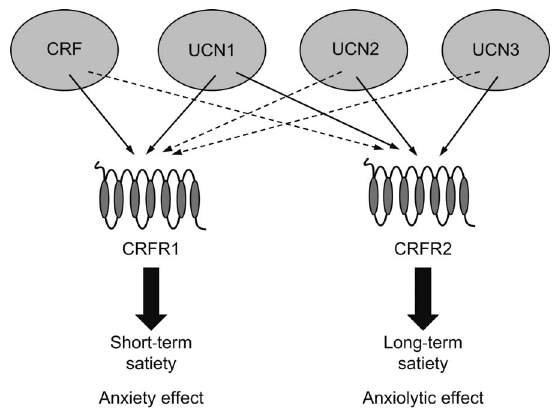
Figure 1 CRF family peptides and CRF